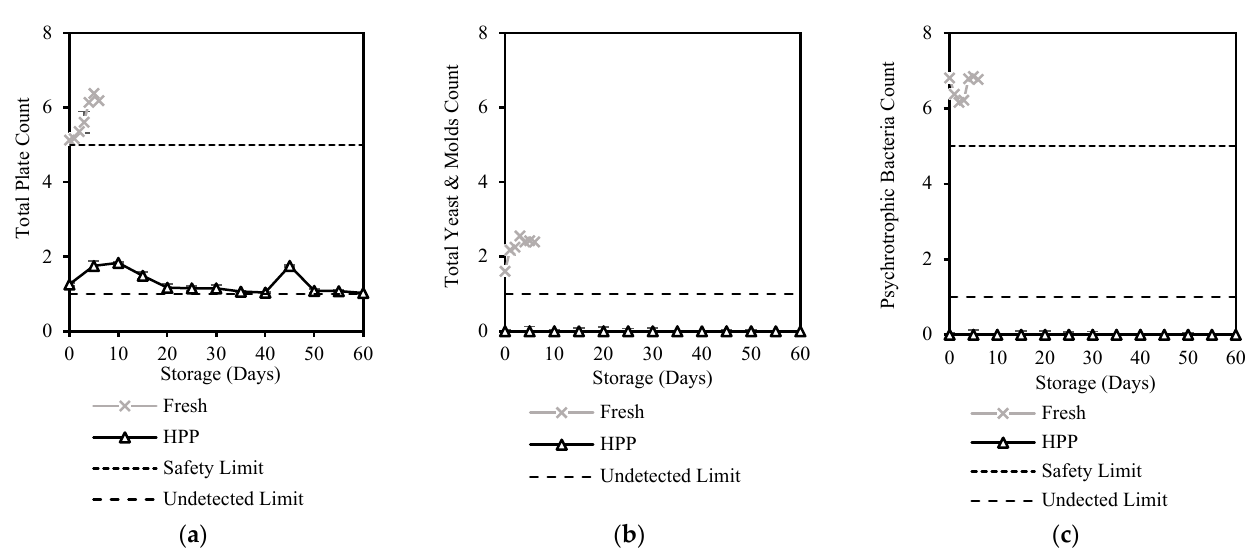
Figure 1. Changes in ( a ) Total Plate Count, ( b ) Total Yeast and Molds Count, and ( c ) Psychrotrophic Bacteria Count of HPP and ESL milk during 60-day storage (log10 CFU/mL).